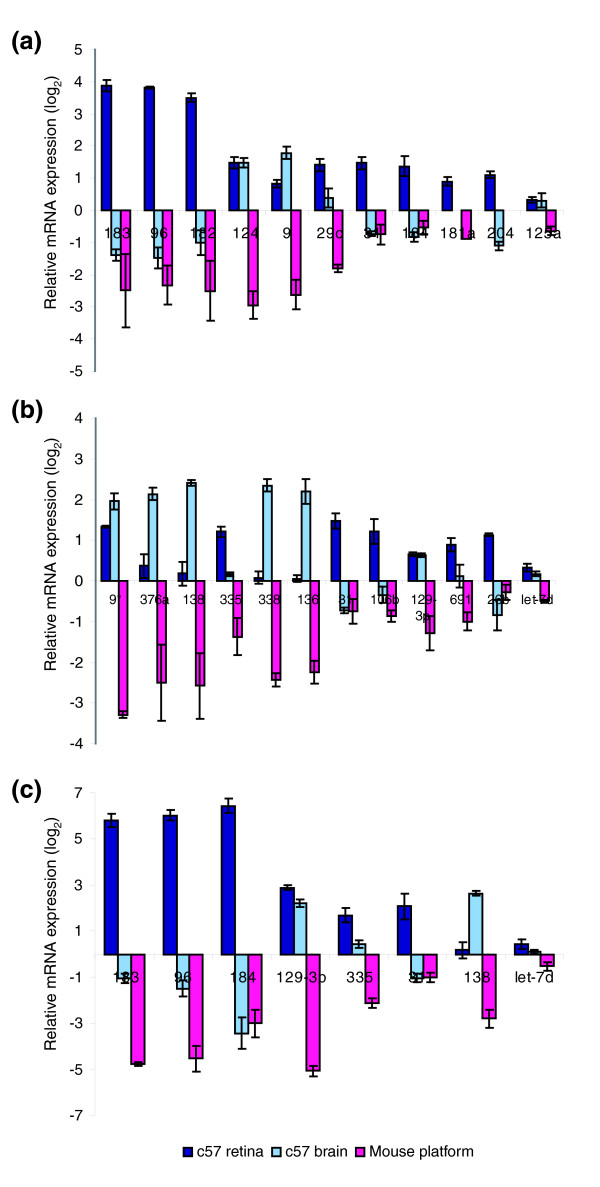
Comparative expression of selected miRs in the retina, brain, and mouse platform. Bars represent deviations from mean expression levels for each microRNA (miR) on a log2 scale in c57 retina (dark blue), c57 brain (light blue), and mouse platform (magenta). (a) Relative expression of some known retinal miRs. (b) Relative expression of miRs with novel retinal specificity. Panels a and b display data from miR microarray experiments. (c) Quantitative real-time reverse transcription polymerase chain reaction (qPCR) validation of expression of selected miRs. Note that columns are in descending order of difference between retinal and platform expression; y-axes are to different scales; and bars for miR-181a in brain and miR-204 in mouse platform are missing in panel a because of incomplete data.